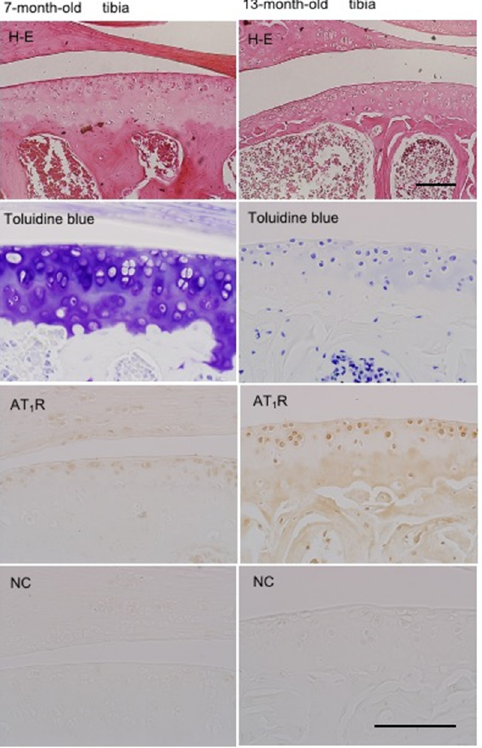
Figure 7. Immunohistochemical analysis of articular cartilage from mice at 7 and 13 months of age, using rabbit anti-AT 1 R antibody. Sections of the articular cartilage of tibias were stained with hematoxylin and eosin (H&E) and toluidine blue. Cartilage tissue of 7-month-old tibias had a metachromatic appearance with toluidine blue staining, and AT 1 R was detected on the surface of articular cartilage. On the other hand, the cartilage tissue of 13-month-old tibias did not have a metachromatic appearance after toluidine blue staining, but AT 1 R was detected throughout the articular cartilage. Negative controls (NC) showed no detectable signals. Scale bars = 100 μ m.